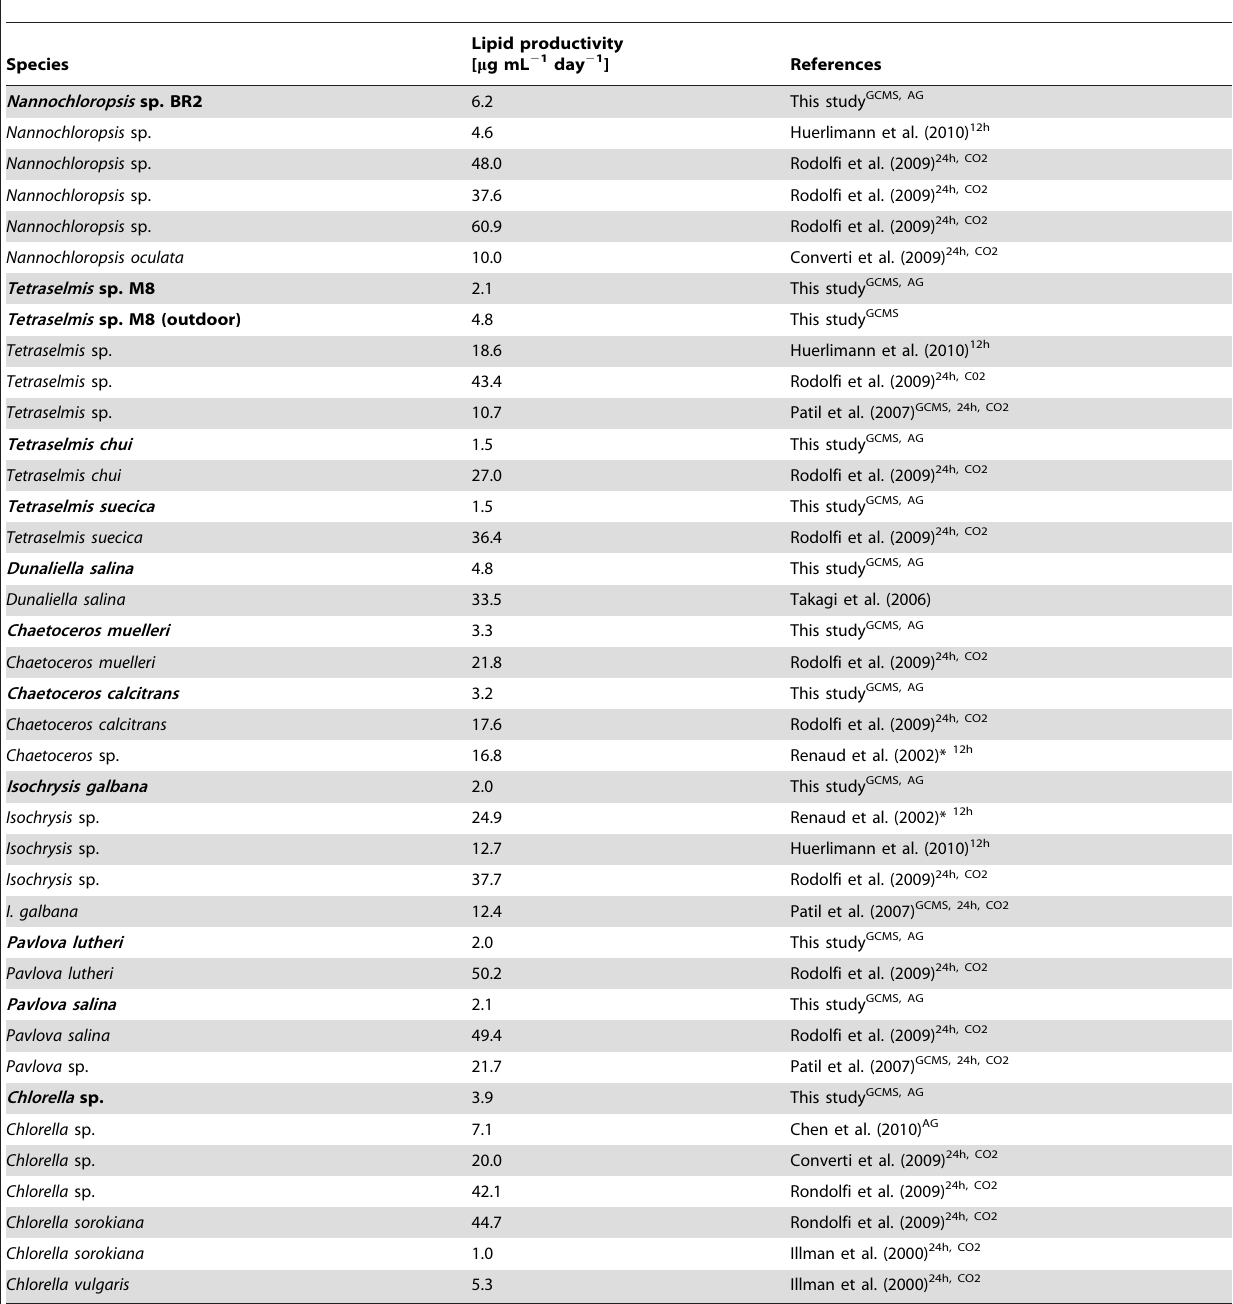
Table 4. Comparison of FAME productivity ( m g mL 2 1 day 2 1) of present study microalgae with lipid productivity of microalgae species from other